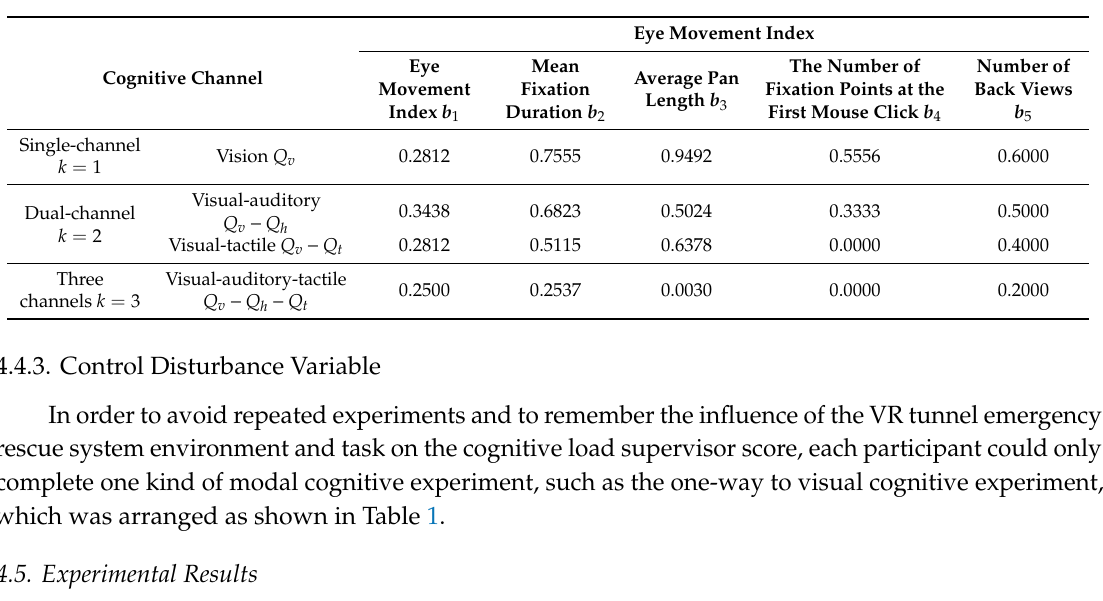
Table 5. Dependent variable.